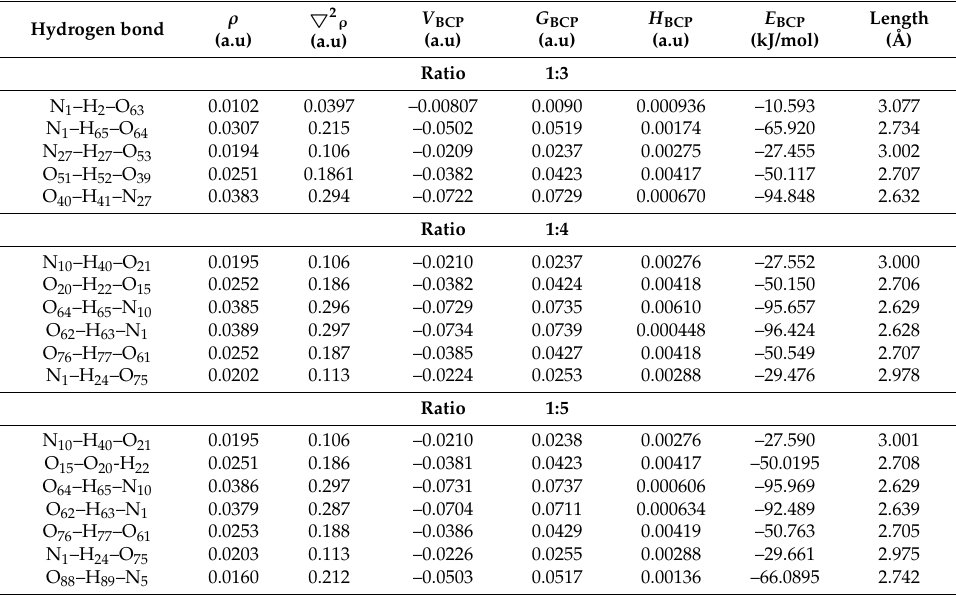
Table 5. Topological parameters for bonds of interacting atoms of the three ratios of MIPs. Hydrogen bond